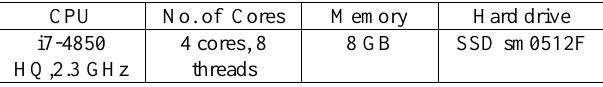
Table 2. Specification of the test PC.